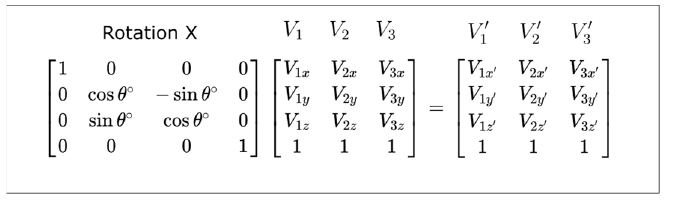
Figure 2. Applying a transformation to a group of vertices.